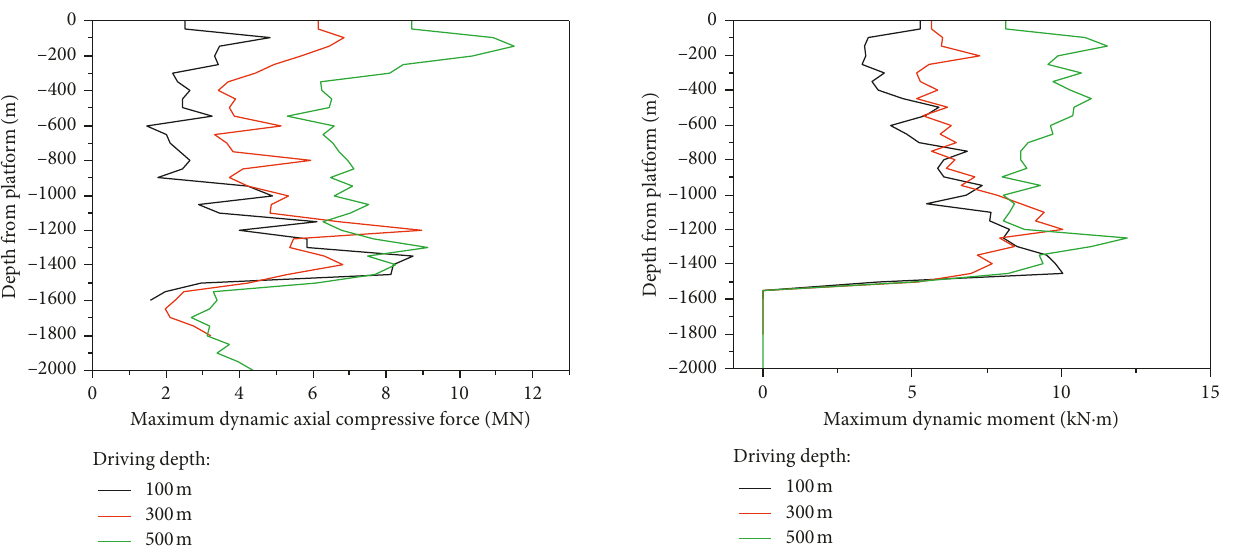
Figure 28: Effect of driving depth on maximum dynamic axial compressive force.